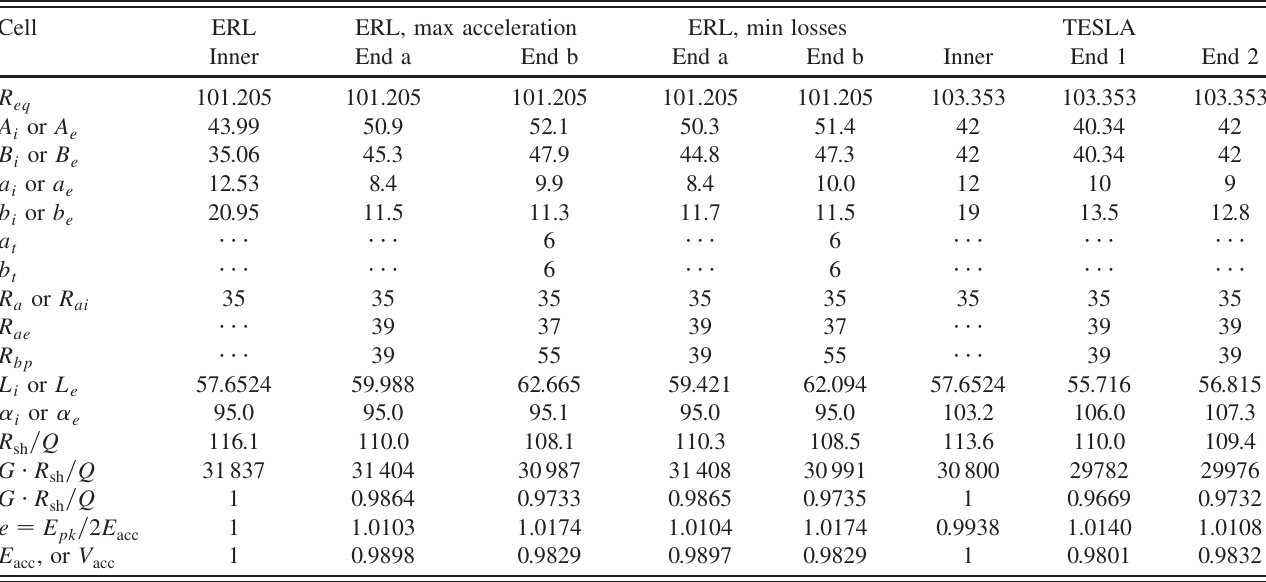
, L and L ) are tuned for 1300 eq i e